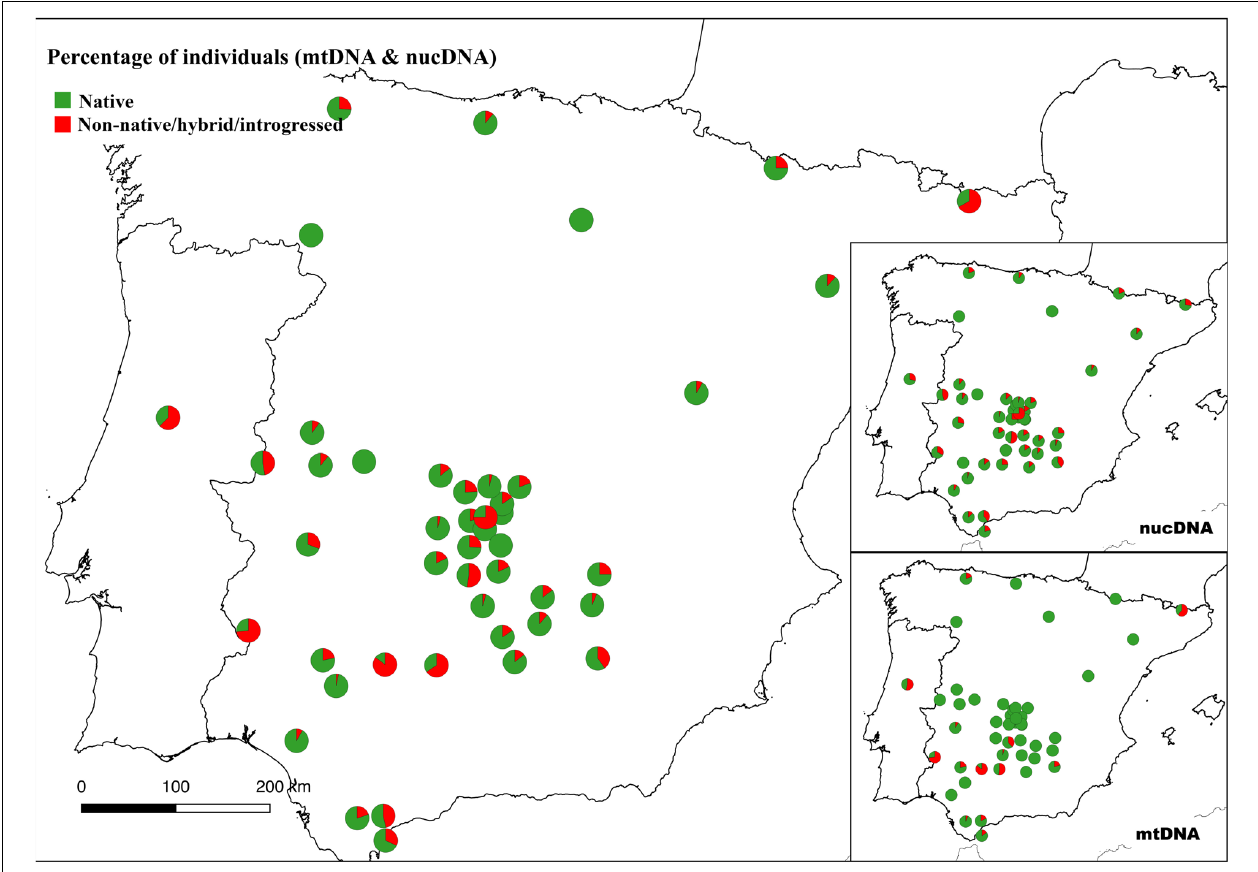
FIGURE 6 | Proportion of native and non-native red deer by population in the Iberian Peninsula. Individuals were classified according to both nuclear (nucDNA) and mitochondrial (mtDNA) DNA content (see section “Materials and